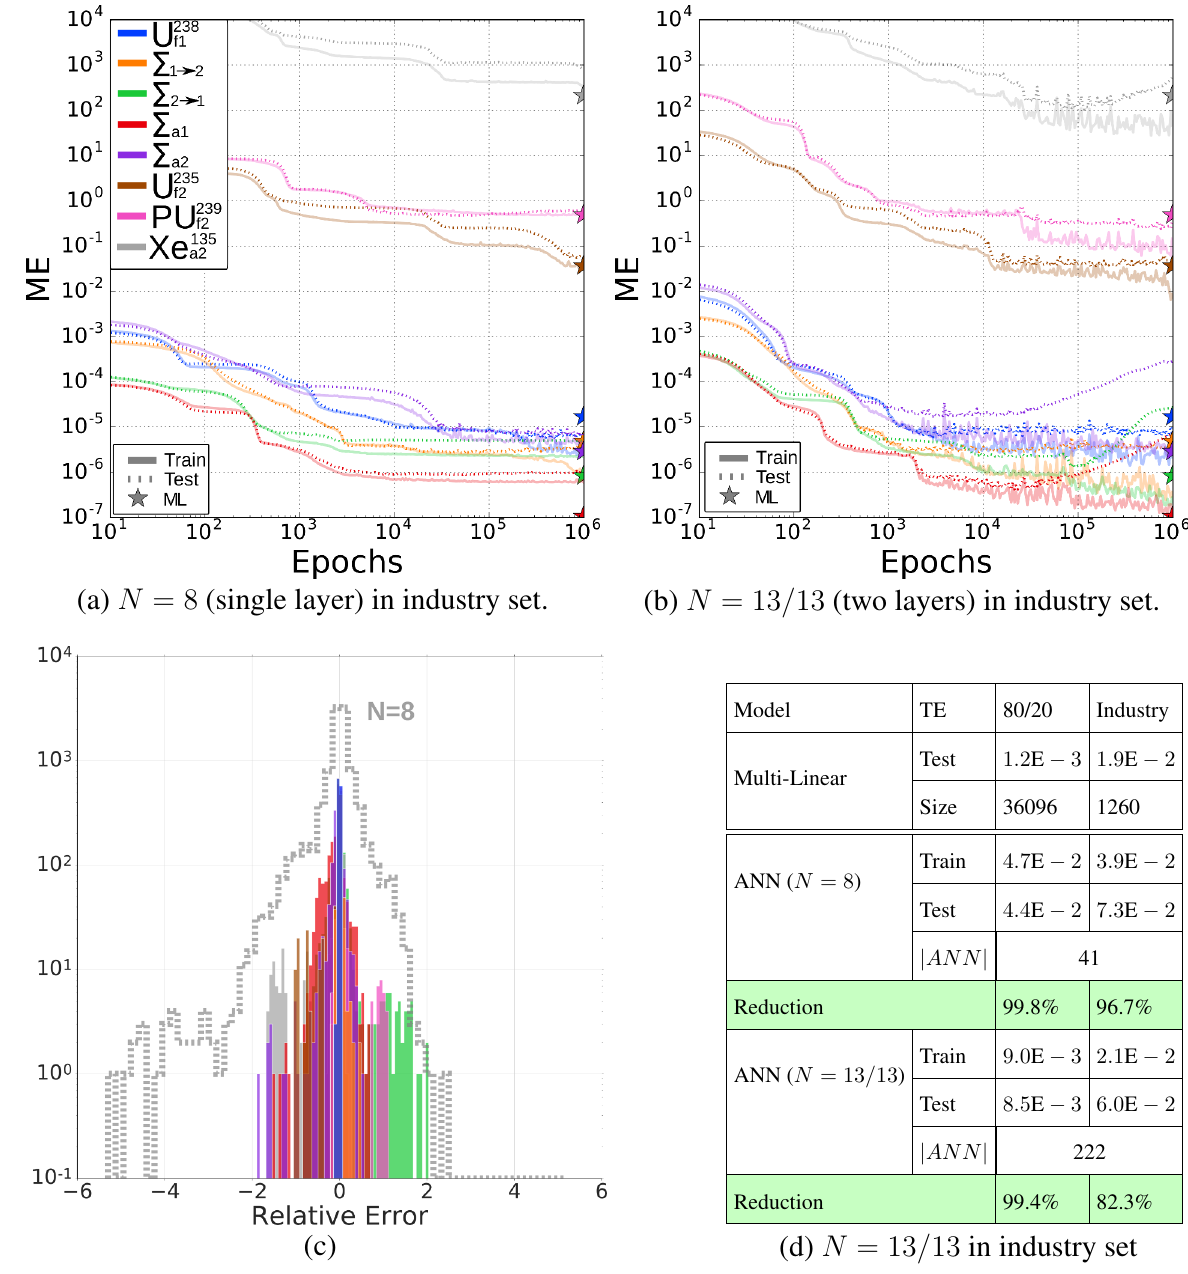
Figure 2: (c) Error histogram discriminated by cross section. (d) Total error (TE) and reduction for the 80/20 % and the Industry data set. Common legend for the cross